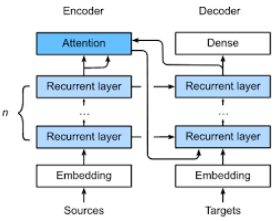
Figure 1. Sequence to Sequence